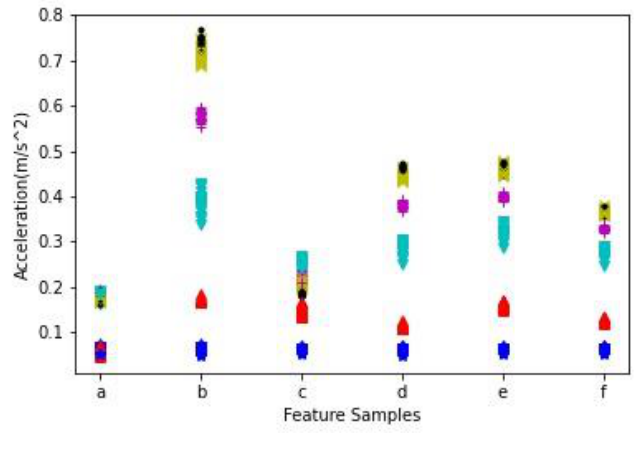
Figure 4. Feature Figure 4. Feature samples.